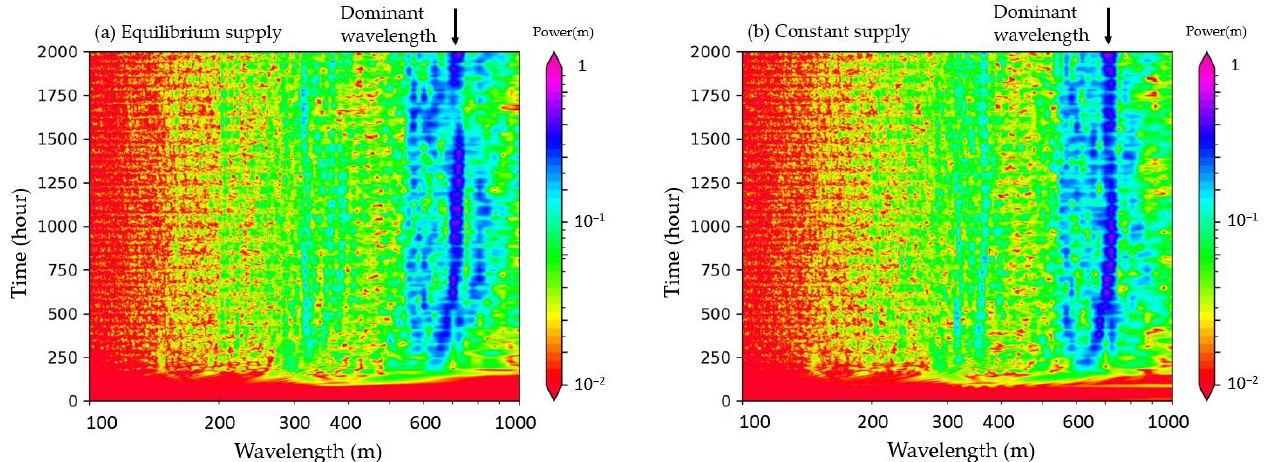
Figure 11. FFT analysis of the dominant wavelength in Case 2. ( a ) Equilibrium sediment supply. ( b ) Constant sediment supply.